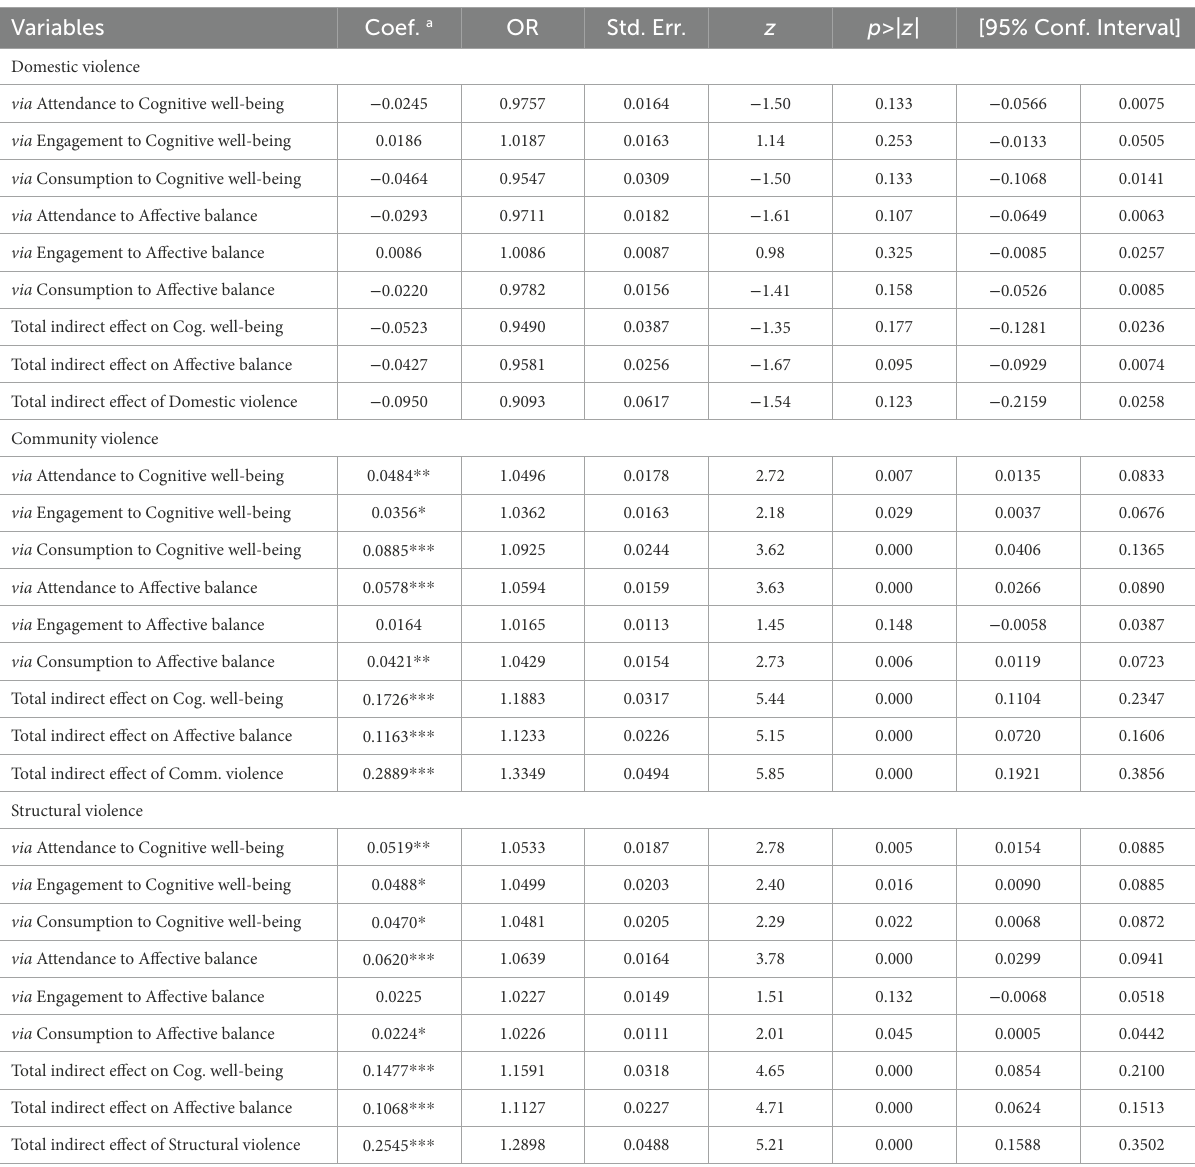
TABLE 5 Mediation test results, indirect effects of self-perceived victimization variables on subjective well-being dimensions, via cultural participation variables.